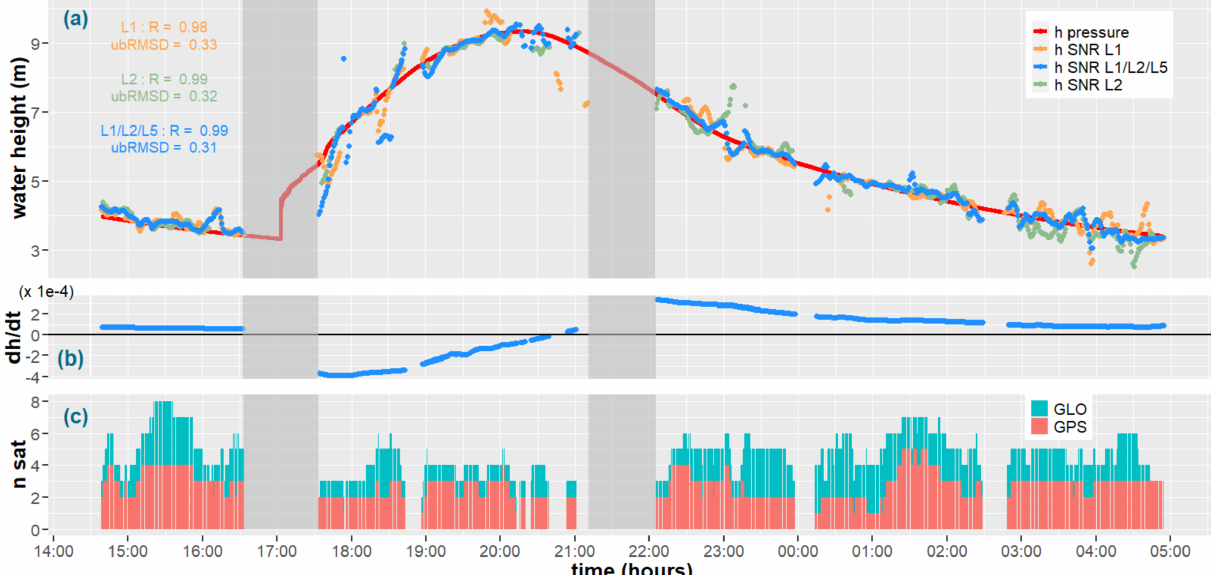
Figure 5. Final results using the adapted dynamic SNR inversion. ( a ) Comparison of h calculated using L1 only (orange), L2 only (green), and L1 + L2 + L5 (blue) frequencies for GPS and GLONASS satellites with pressure water levels (red); . h with L1 + L2 + L5 bands; ( c ) number of GPS and GLONASS satellites for the calculation of h and ( b ) output . h was derived from the relative antenna height h , thus it was negative during rising tides as the relative antenna value of height